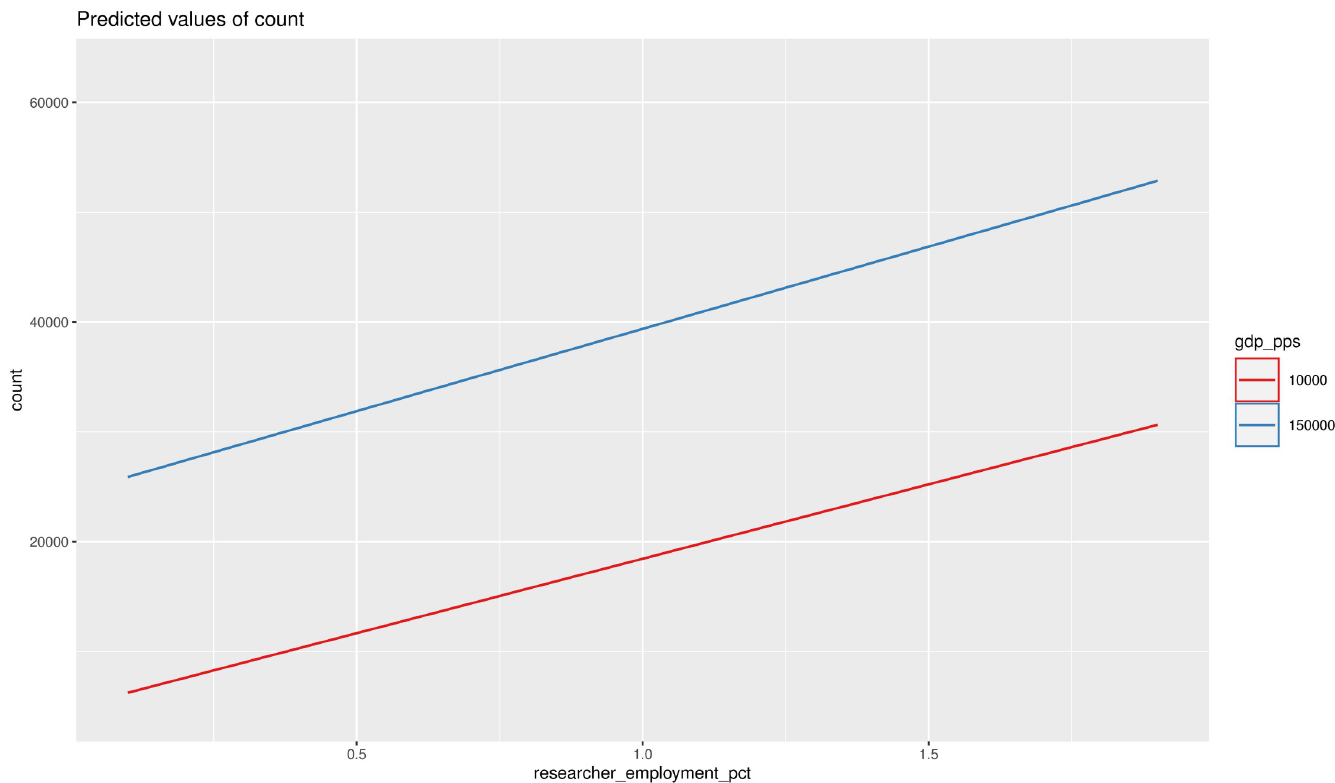
Fig 5. Interaction effects between GDP_PPS and researcher employment percentage (DV: Download count).